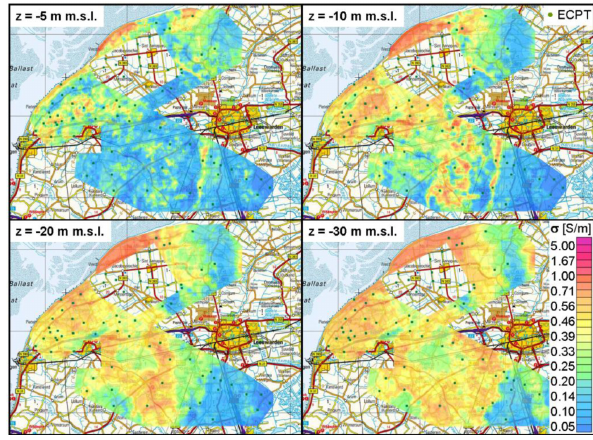
Fig. 9. Depth slices of EC from HEM and SkyTEM